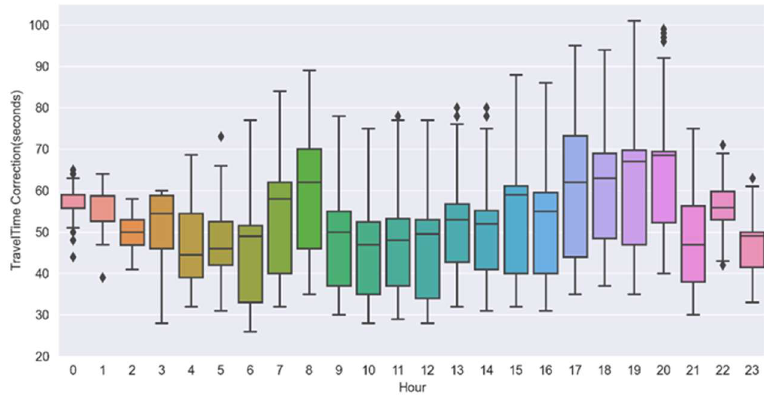
Figure 5. Hourly distribution of completed travel time.